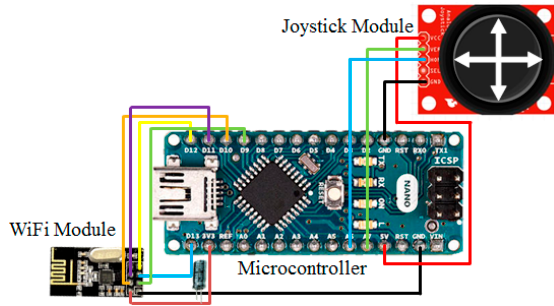
Figure 9. The schematic configuration of the remote controller.